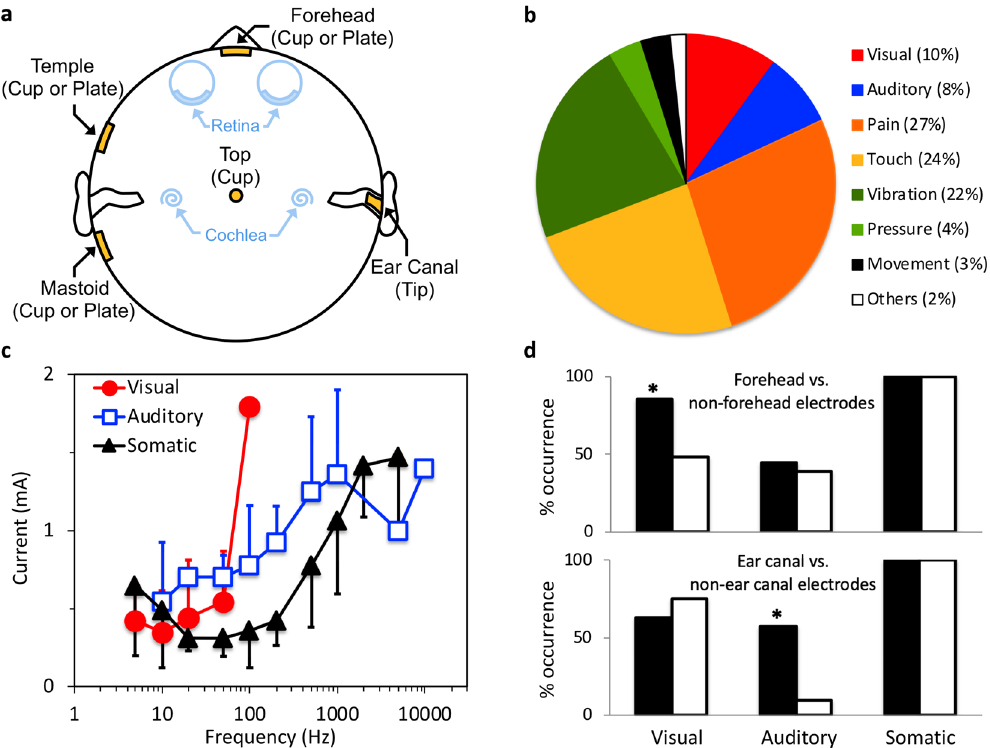
Figure 1. Human sensation evoked by transcranial electric stimulation. The human subject was tested in a double-walled, sound-proof booth, with the light turned off. All stimuli were charge-balanced and delivered through a current source. The sensation threshold was obtained by the method of limits. (a) Electrode montages consisted of eight positions: forehead, top of the head, left and right temple, left and right mastoid, and left and right ear canal (note: only the left temple, left mastoid, and right ear canal electrodes are displayed in the diagram in yellow). The forehead and ear canal electrodes were located closest to the visual and auditory organs: the retina and cochlea, respectively (blue). (b) Distribution of 983 reported sensations by type and other neural and muscular activities (see text for details). (c) Visual, auditory, and somatic sensitivity thresholds in electric current are plotted as a function of stimulus frequency (5 to 10,000 Hz) averaged over all electrode positions. Error bars represent one standard deviation of the mean across all electrode positions. (d) Percentage (y-axis) for each of the three types of sensation (regardless of stimulus frequency and level) for two subsets of electrode configurations: those containing forehead electrode (filled bars in the top panel) vs. non-forehead electrodes (open bars); those containing ear canal electrodes (filled bars in the bottom panel) vs. non-ear-canal electrodes (open bars). The asterisk ( * ) indicates a significant difference between two occurrences [two-tailed binomial distribution test: z(n 1 = 27, n 2 = 33) = 2.97, p = 0.003 for the visual sensation between forehead and non- forehead electrodes; z(n 1 = 38, n 2 = 20) = 3.49, p = 0.0005 for the auditory sensation between ear canal and non- ear canal electrodes. See Procedures in